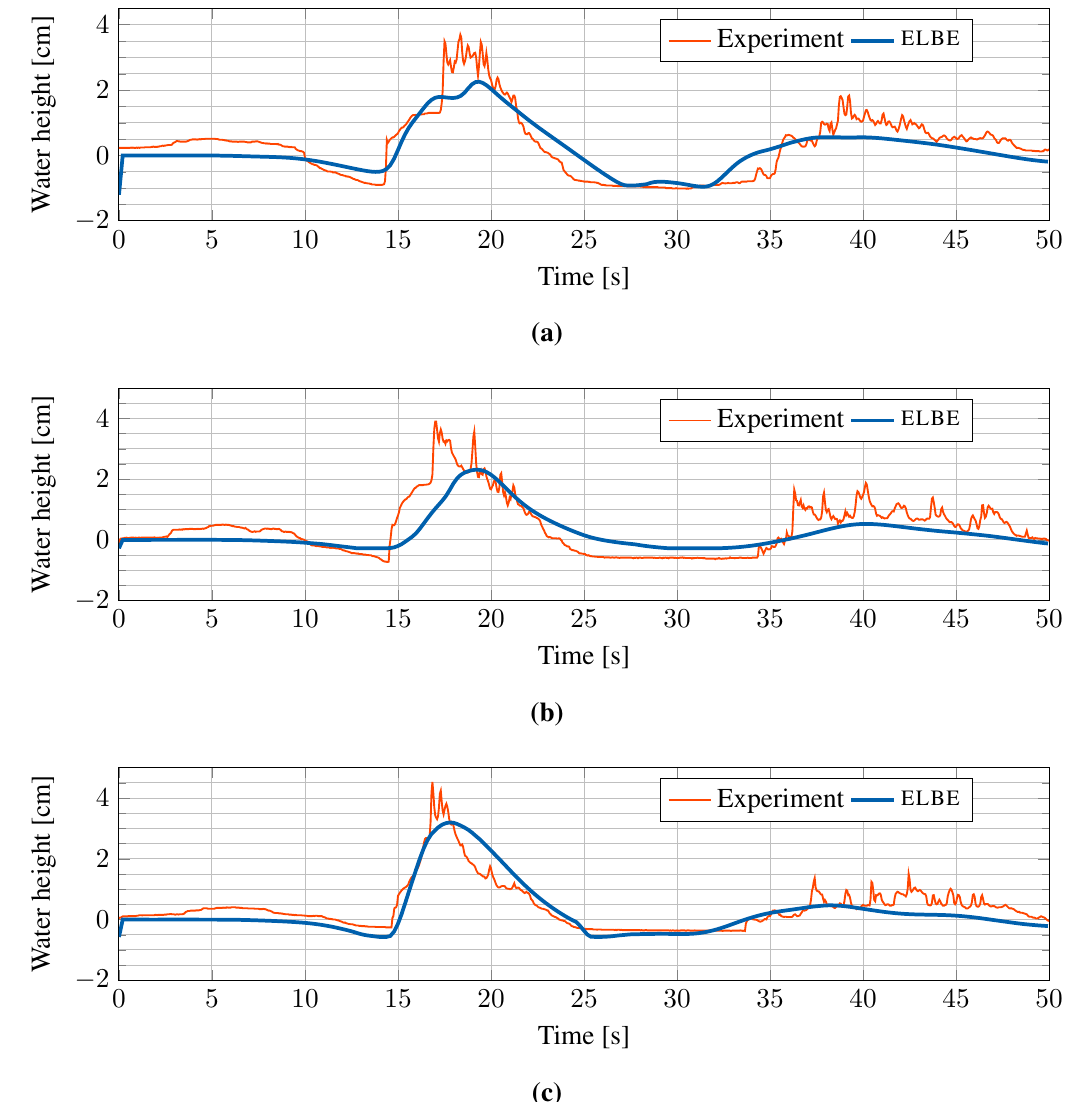
Figure 8. Comparison of experimental [38] and NSW-LBM results for three different wave gauges, A, B and C, for the Catalina Benchmark 2 of the Monai Valley. ( a ) Probe A, (cid:126)x (4.521 m, 1.196 m); ( b ) Probe B, (cid:126)x 2.196